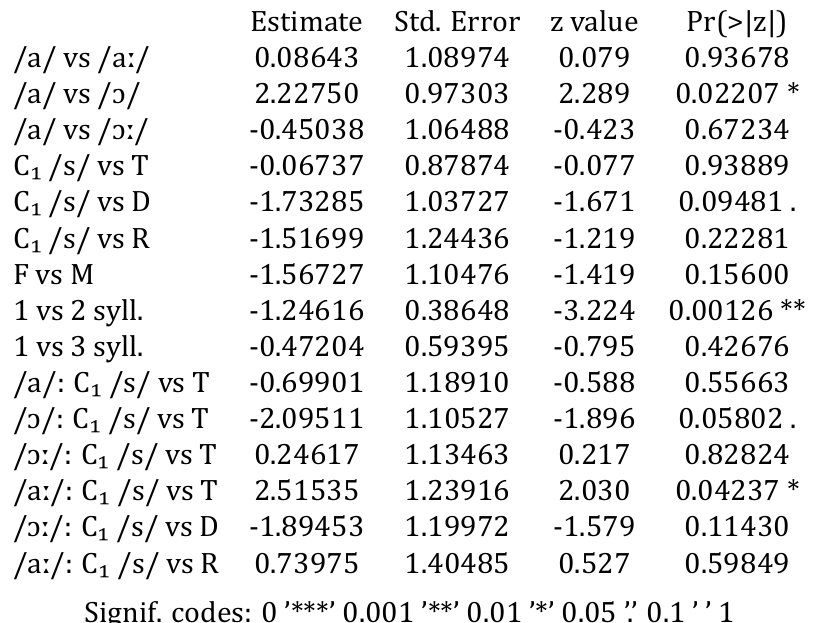
Table A.18: Pre-aspiration occurrence prior to C₂ fortis plosive as a dependent